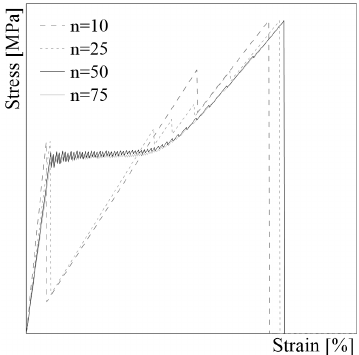
Figure 2. Mesh sensitivity